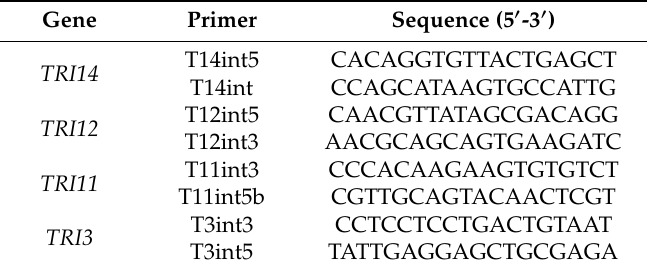
Table 5. Target trichotecene TRI genes, primers and sequences used for the PCR